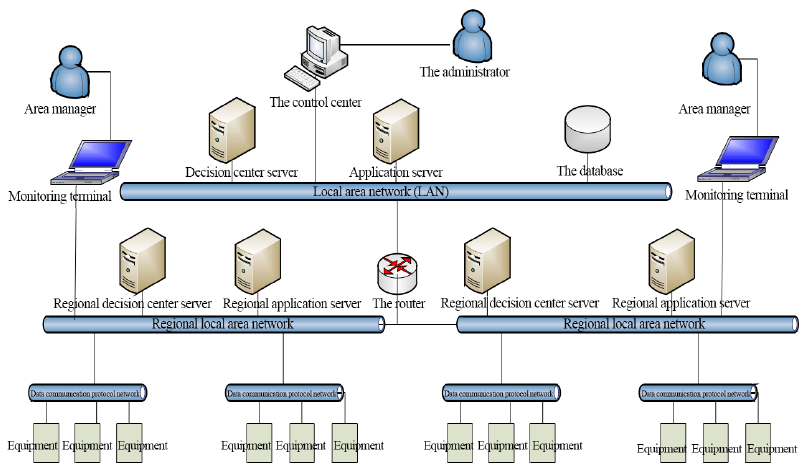
Figure 3. The model of the distributed system.